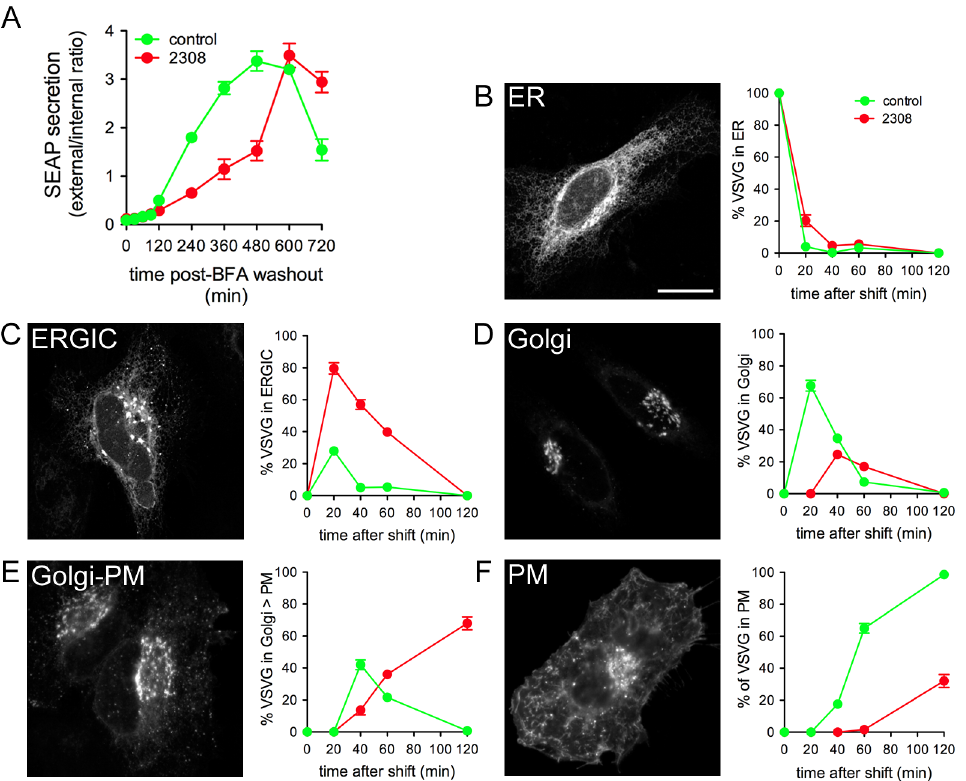
Figure 6. Brucella impairs host cell secretion during infection. (A) Quantification of SEAP secretion in uninfected (control) and B. abortus 2308- infected (2308) HeLa cells. HeLa cells were transfected with pSEAP-2 for 16 h, then infected with B. abortus 2308. At 24 h pi, SEAP protein production was synchronized as described in the Materials and Methods and the external and internal SEAP activity measured at various times post- synchronization. Data show SEAP ratios (external/internal SEAP activity) from uninfected or infected cells. (B–F) VSV-Gts045-GFP trafficking in either control or B. abortus 2308-infected HeLa cells. HeLa cells were either mock-infected or infected with DsRed m -expressing B. abortus 2308. Twenty-four hours pi, cells were transfected with plasmid encoding VSV-Gts045-GFP and incubated at 40 u C for 20 h. After 30 min of cycloheximide treatment to stop VSV-Gts045-GFP production, cells were shifted to 32 u C, then fixed and immunostained at the indicated time points and VSV-Gts045-GFP localization was examined. (B) Percentage of VSV-Gts045-GFP in the ER, (C) in the ERGIC, (D) in the Golgi apparatus, (E) in the Golgi to plasma membrane (Golgi-PM) compartments and (F) % of VSV-G at the plasma membrane (PM). Data are expressed as a percentage of where VSV-G is located in the defined compartment, as shown in the representative confocal micrographs and are the means 6 SD from three independent experiments.